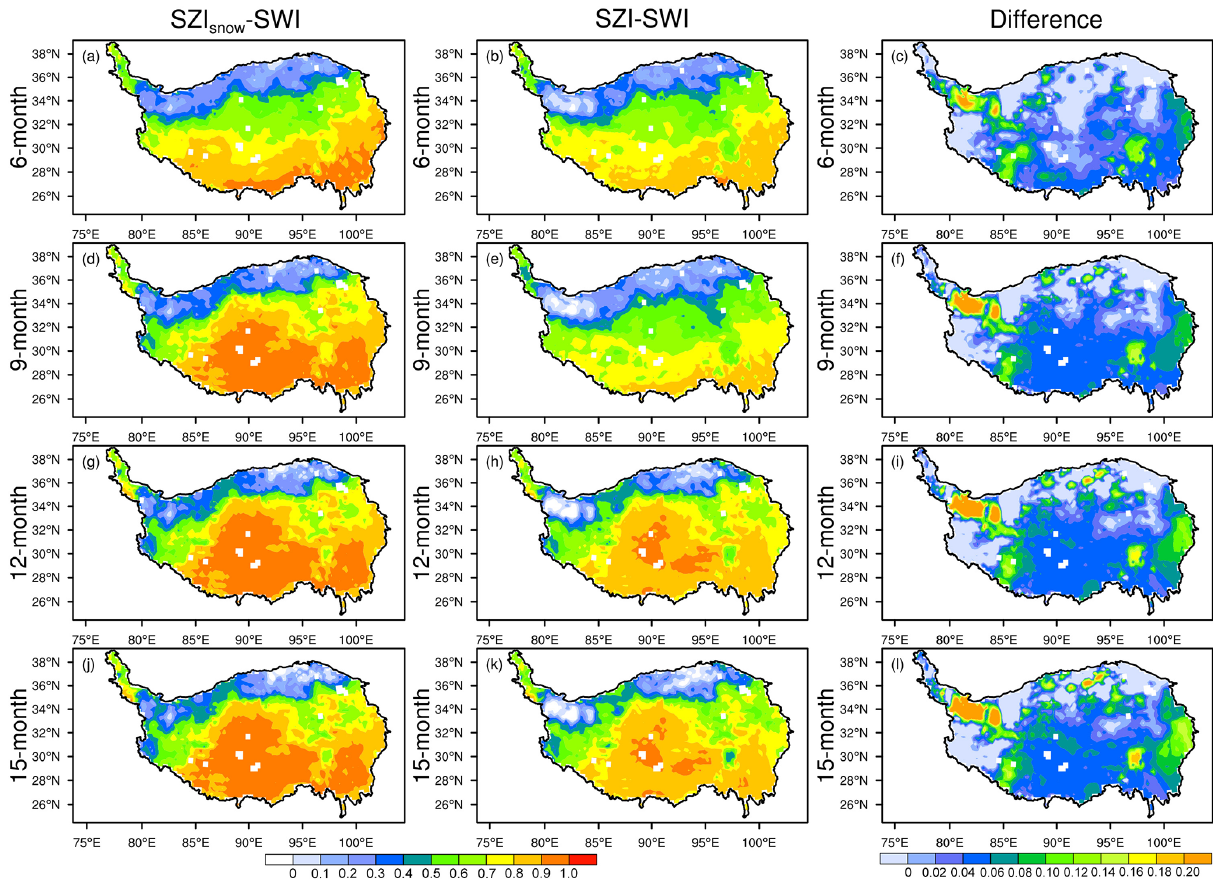
Figure 6. Spatial distribution of correlation coefficients of the SZI snow –SWI (left column, a, d, g, j ) and those of the SZI–SWI (middle column, b, e, h, k ), and the differences between the two (right column, c, f, i, l show the left column minus middle column) over the Tibetan Plateau at different timescales (6, 9, 12, and 15